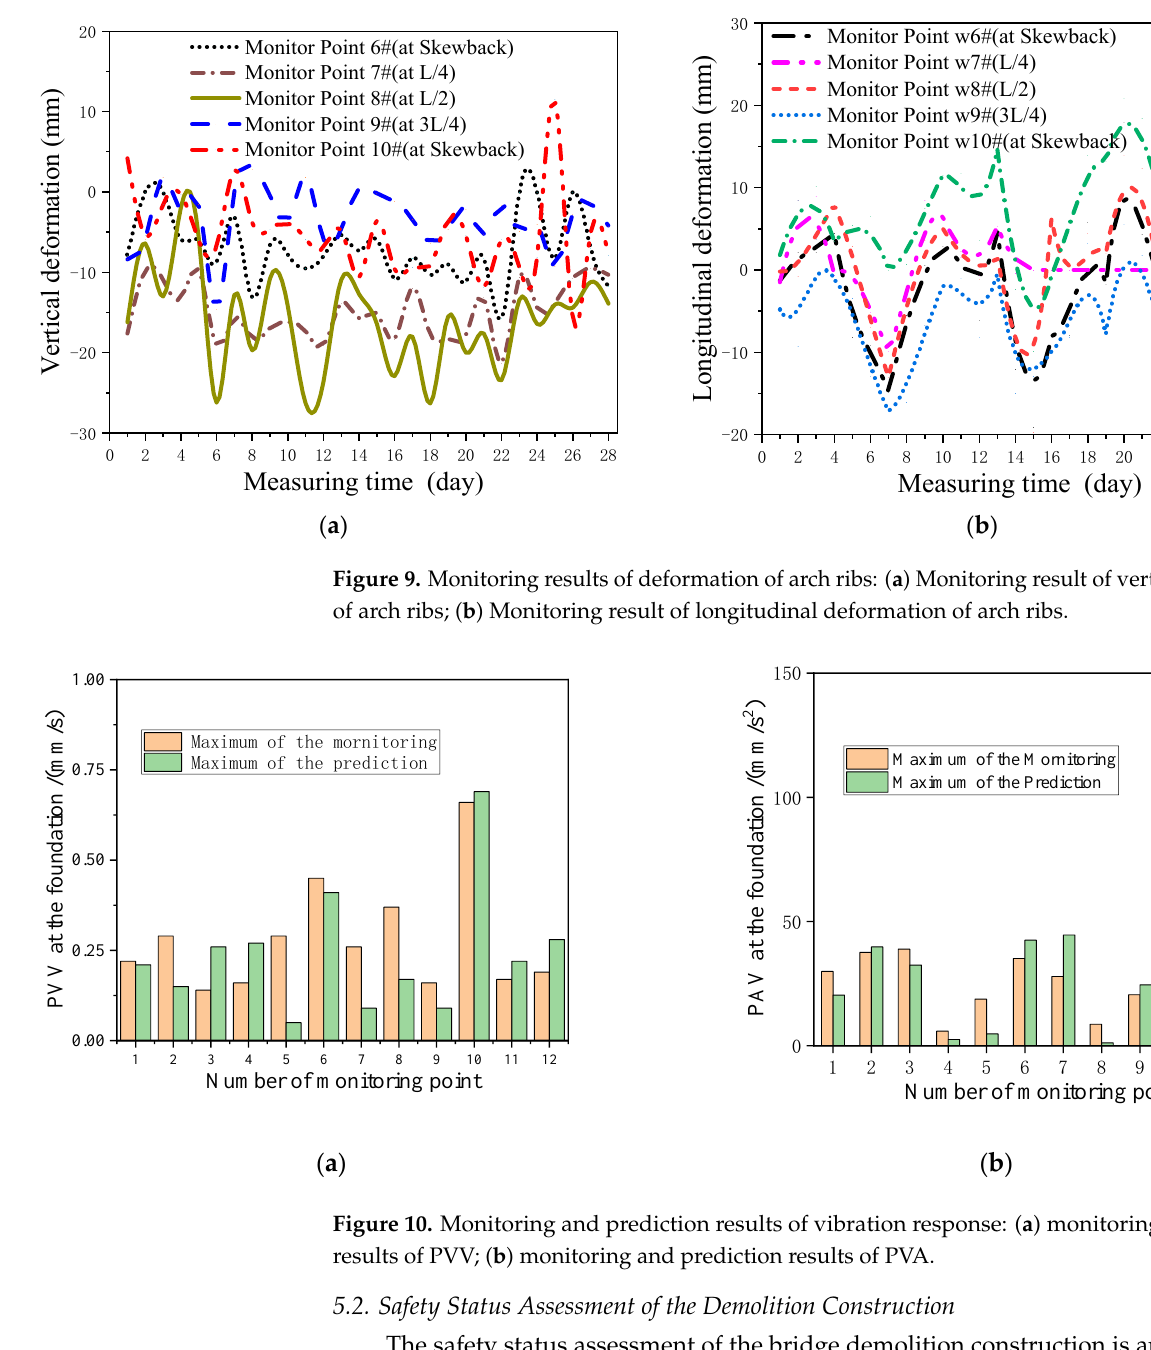
Figure 10. Monitoring and prediction results of vibration response: ( a ) monitoring and prediction results of PVV; ( b ) monitoring and prediction results of PVA.